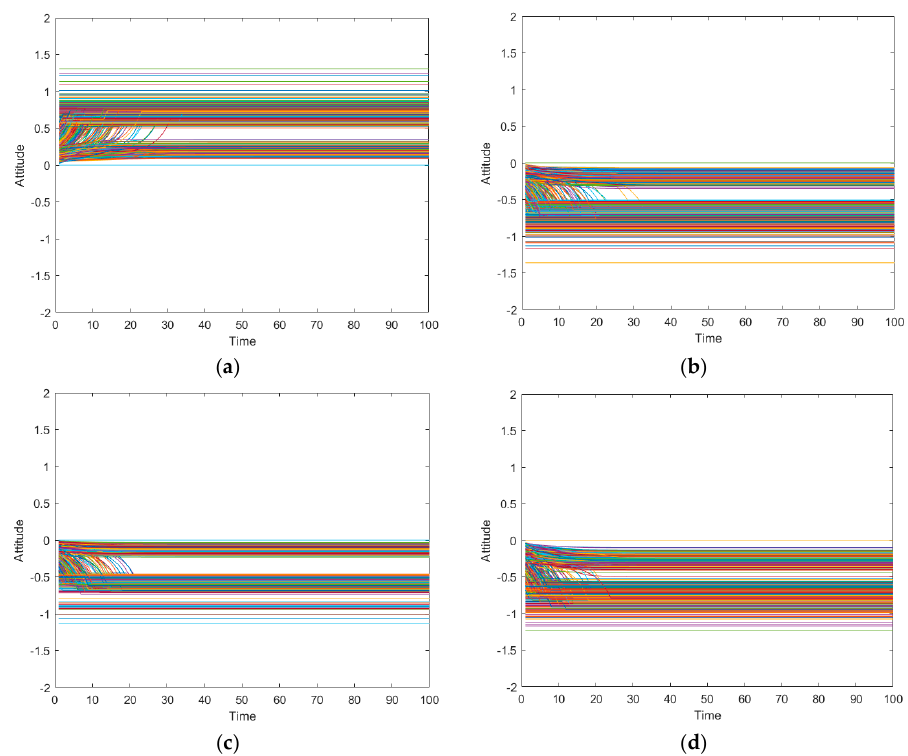
Figure 9. The changes of attitudes with times of interaction under different emotion proportion. ( a ) The changes of attitudes with times of interaction when joy accounts for 70%, and other three respectively accounts for 10%. ( b ) The changes of attitudes with times of interaction when anger accounts for 70%, and other three respectively accounts for 10%. ( c ) The changes of attitudes with times of interaction when sadness accounts for 70%, and other three respectively accounts for 10%. ( d ) The changes of attitudes with times of interaction when fear accounts for 70%, and other three respectively accounts for 10%.